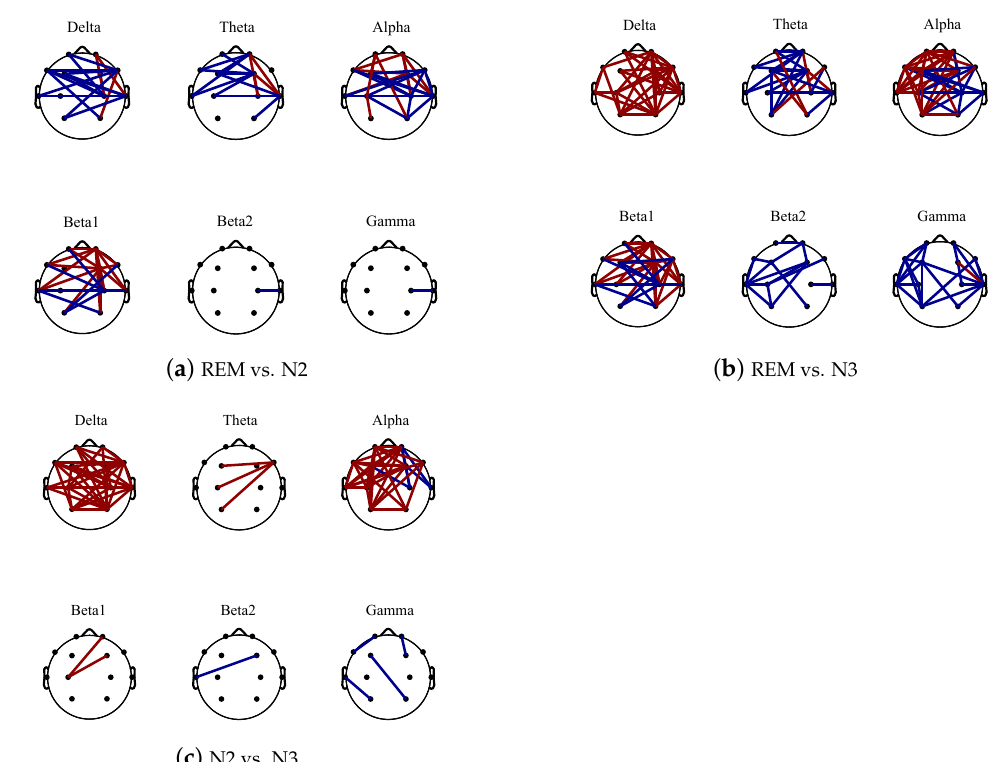
Figure 6. The brain network difference topoplot between REM and N2 (shown in ( a )), REM and N3 (shown in ( b )) and N2 and N3 (shown in ( c )) for different frequency bands. The red line represents the increase area, and the blue line indicates the decrease